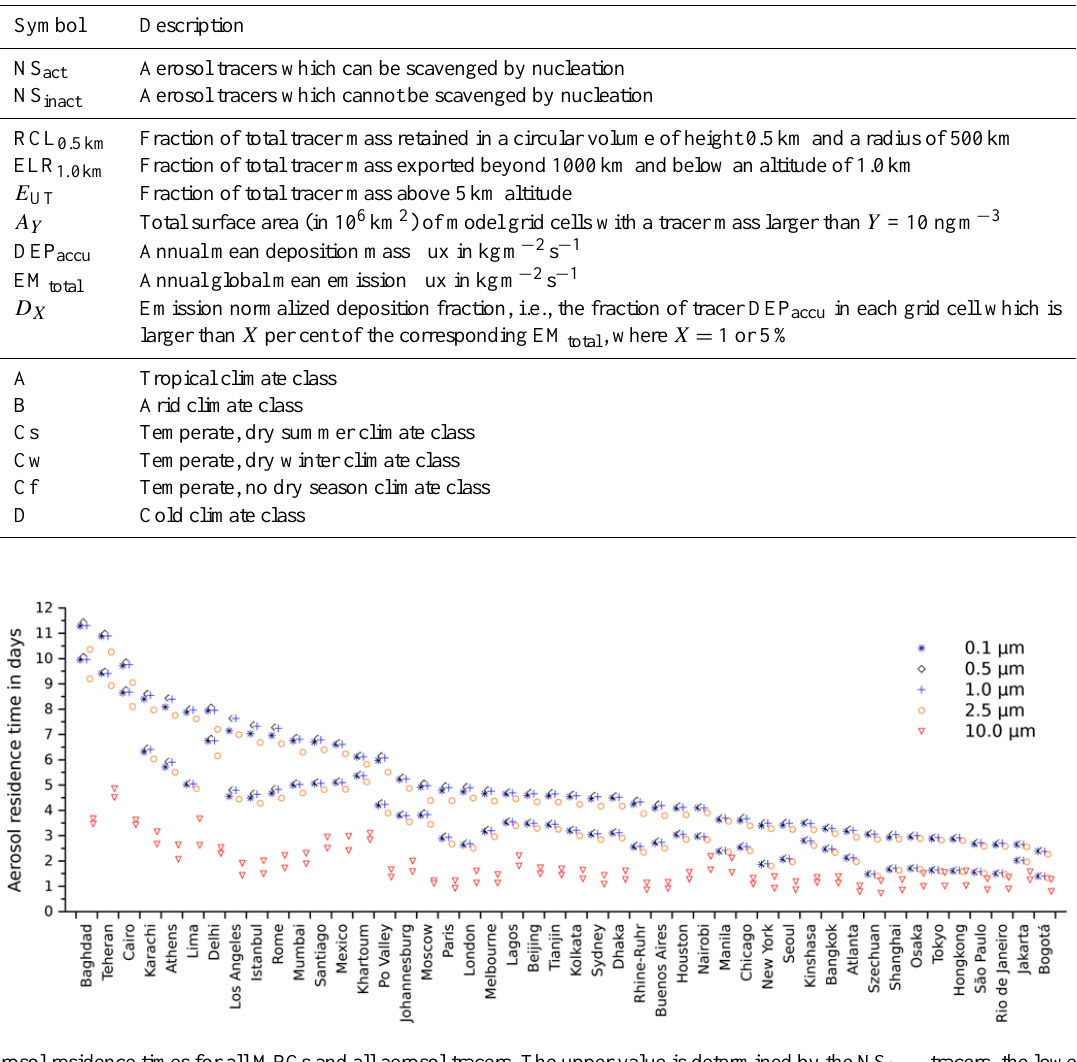
Fig. 1. Aerosol residence times for all MPCs and all aerosol tracers. The upper value is determined by the NS inact tracers, the lower value by the NS act